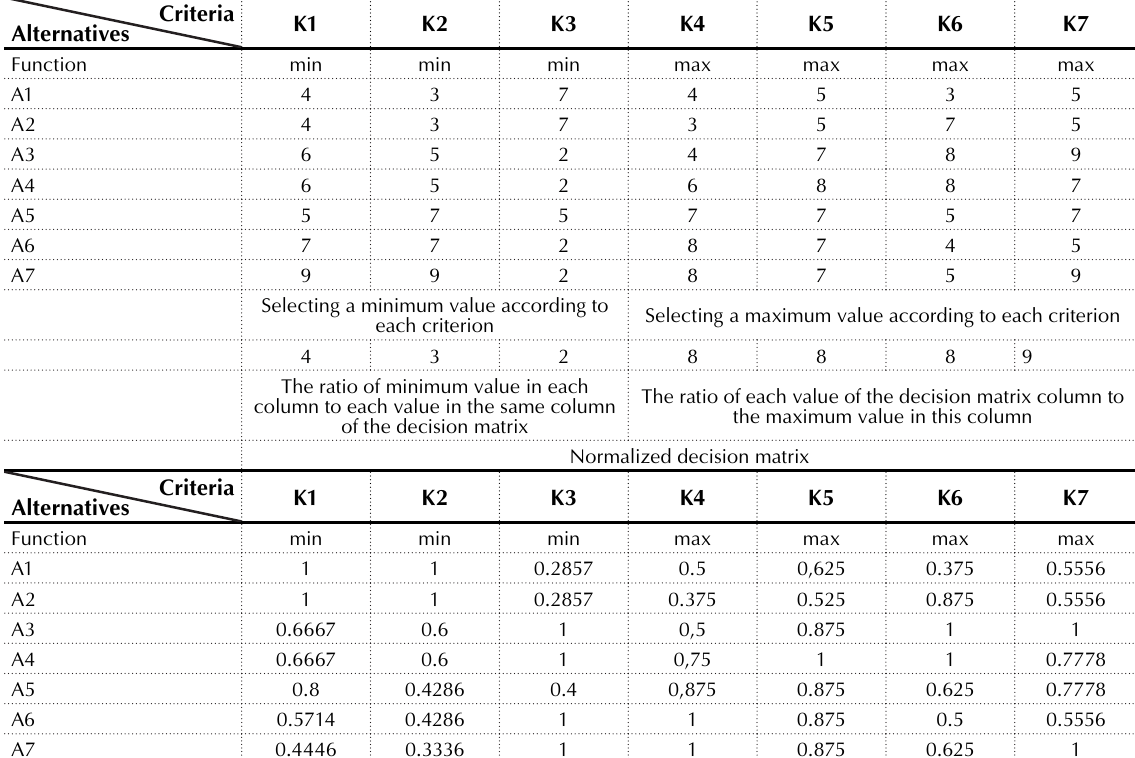
Table 3. Normalized decision matrix